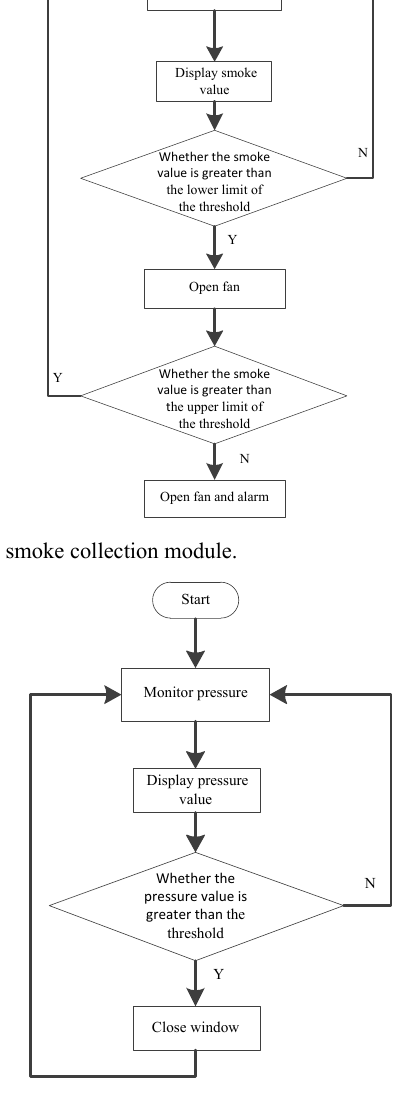
Fig. 8. The flowchart of the pressure collection